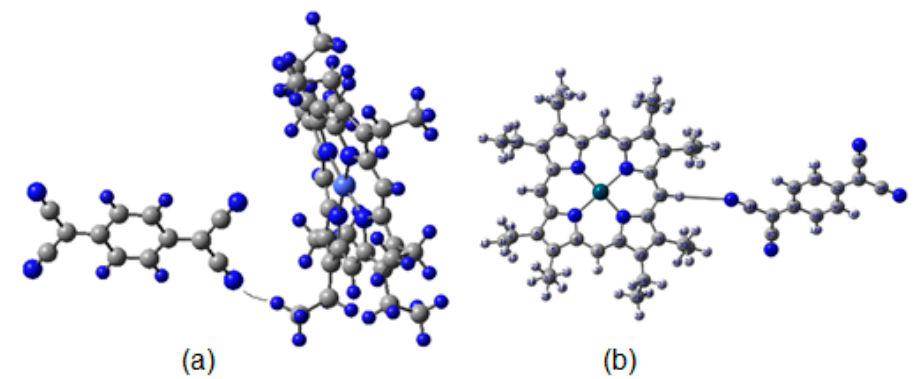
Figure 2. Hydrogen bond complexes between cobalt octaethylporphyrin (CoOEP) and tetracyano- π -quinodimethane (TCNQ): ( a ) hydrogen atoms with an aliphatic source and ( b ) hydrogen atoms with an aromatic source.